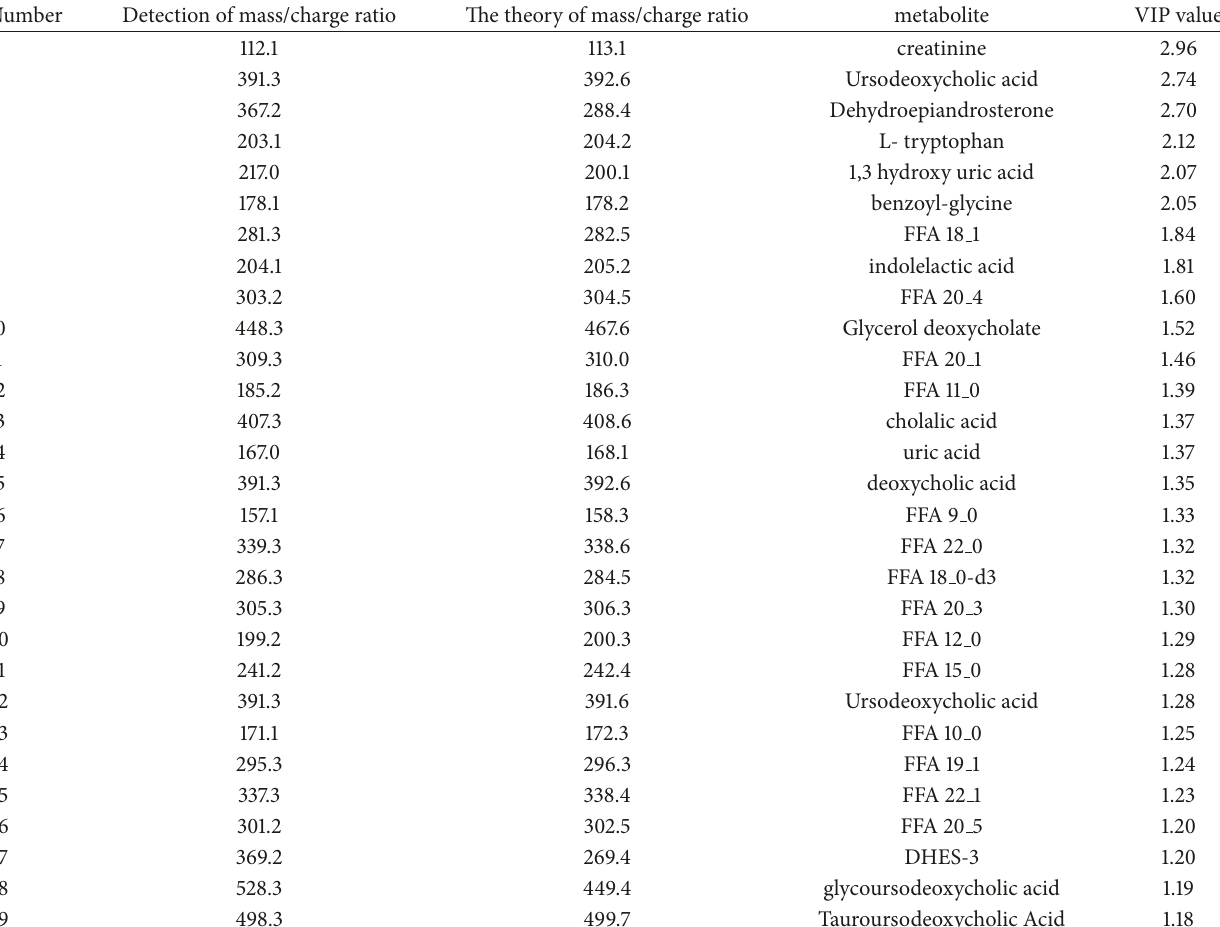
Table 9: Identification of characteristic metabolites.